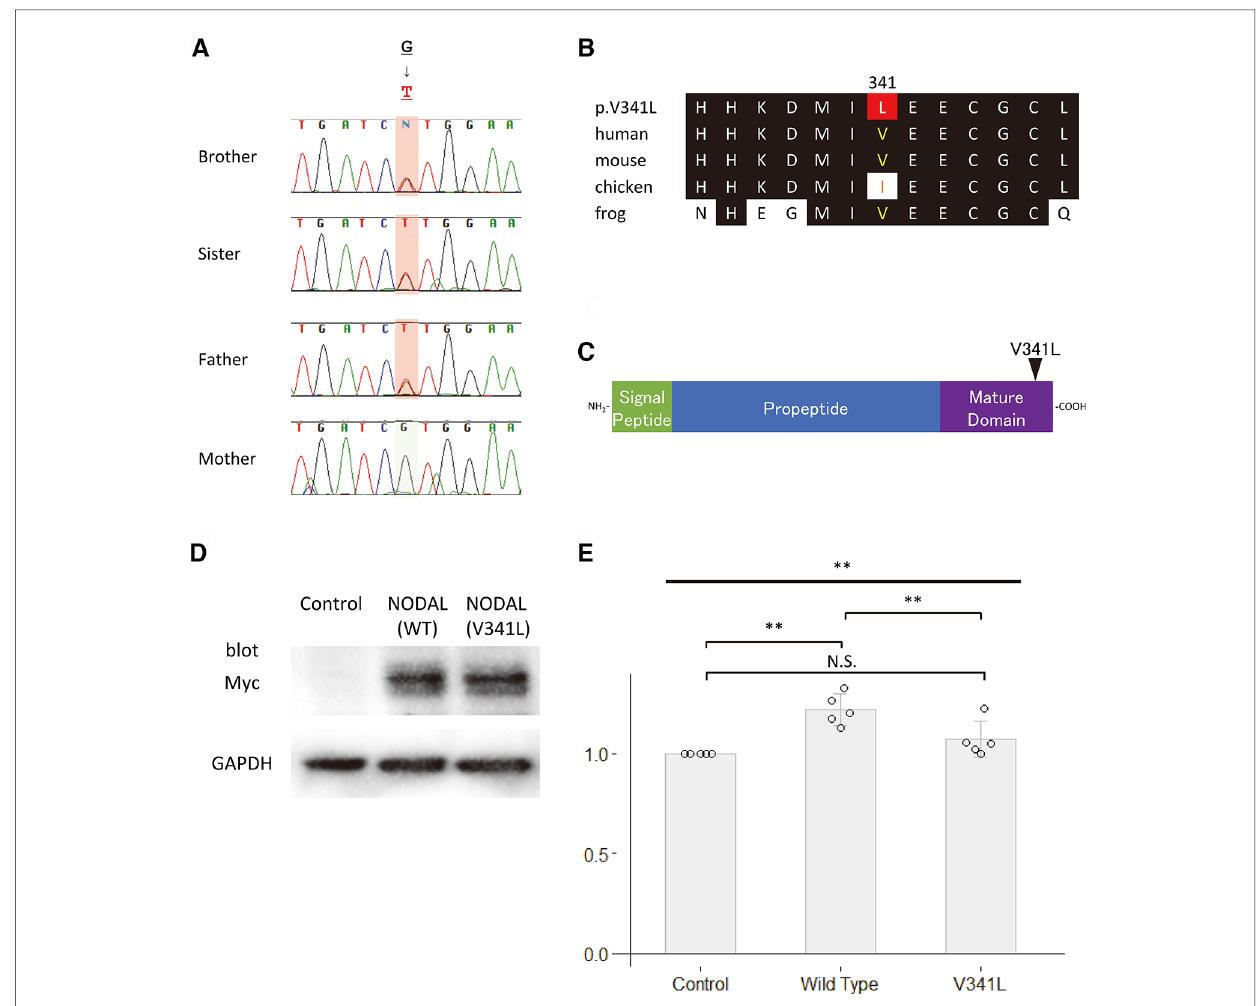
FIGURE 2 Functional analyses of NODAL . ( A ) Sequence chromatograms of NODAL in the family. ( B ) The conservation of alignment of the variant in the coding regions between species. Changes in amino acids are highlighted in red. The position of V341 is well-conserved between species. ( C ) Structure of the human NODAL protein. The position of the variant is indicated by an arrowhead. ( D ) Western blot analysis of the c-Myc-tagged wildtype NODAL and the variant NODAL (p.V341l) proteins. Glyceraldehyde-3-phosphate dehydrogenase, GAPDH, is used as an internal control. ( E ) Fold increase in relative luciferase activity in P19 cells transfected with green fl uorescent protein (GFP) as control, wildtype NODAL or variant NODAL (p.V341l) expression construct, and p(SBE) 4 -Luc ( N =5). All values are expressed as the mean±SD. Signi fi cance was assessed using one-way ANOVA, followed by Tukey ’ s post hoc test. **, p <0.01; N.S., not signi fi